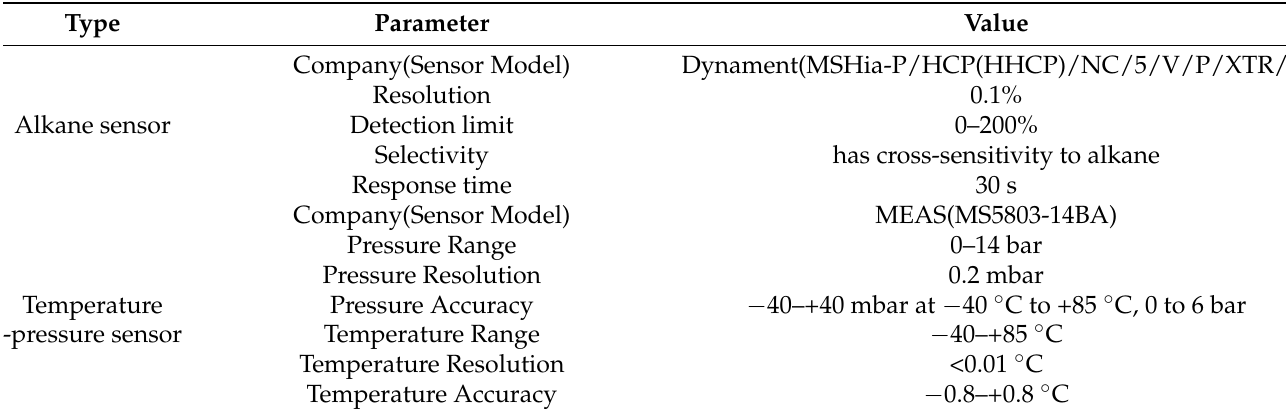
Table 1. Detailed information about the